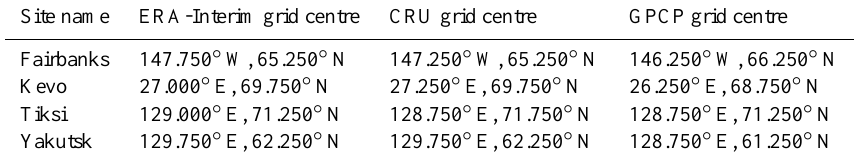
Table 4. Names and coordinates of the grid centres of ERA-Interim, CRU, and GPCP data for the corresponding sites shown in Table